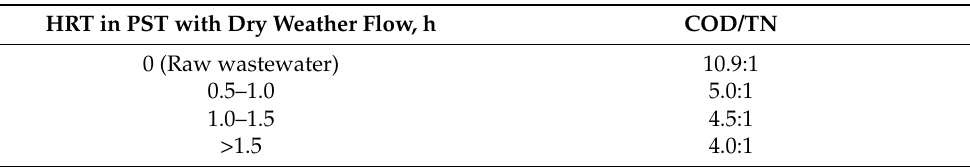
Table 2. COD and TN in typical domestic wastewater as a function of the primary clarification HRT (calculated according to DWA 131,